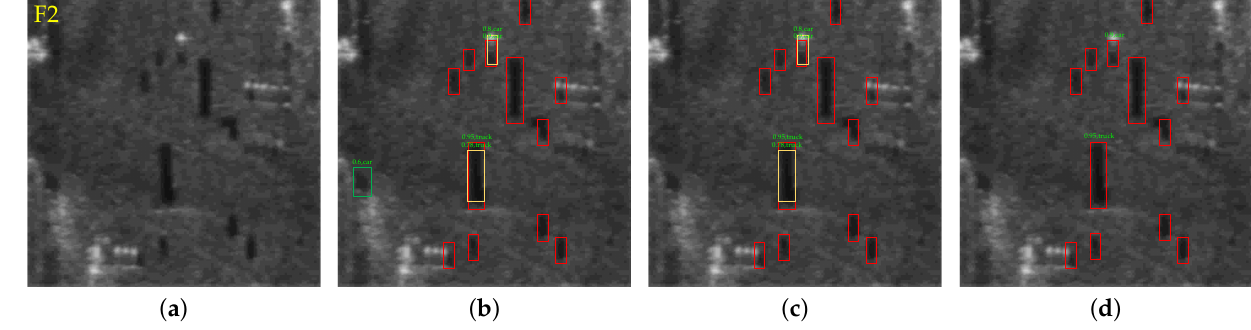
Figure 10. Diagram of detection results. ( a ) Search frame F2. ( b ) Diagram of detection results after using multi-scale Faster-RCNN. ( c ) Diagram of detection results based on confidence. ( d ) Diagram of detection results after using NMS.